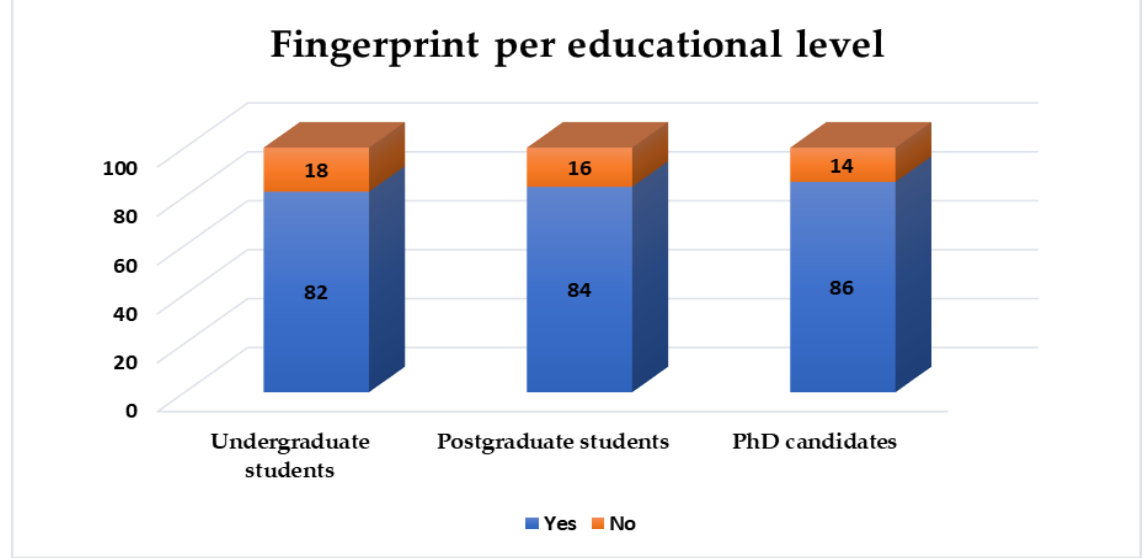
Figure 7. Adopted biometric technique per educational level — fingerprint .